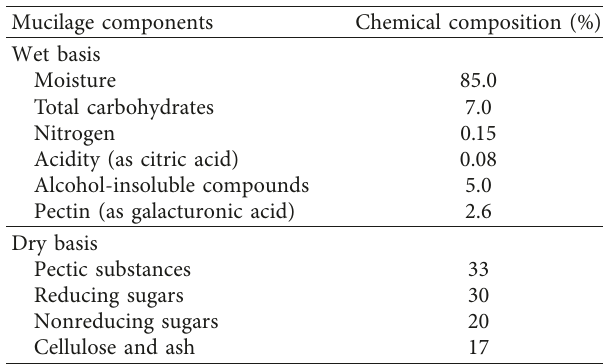
Table 1: Chemical composition, on a wet and dry basis, of coffee mucilage.